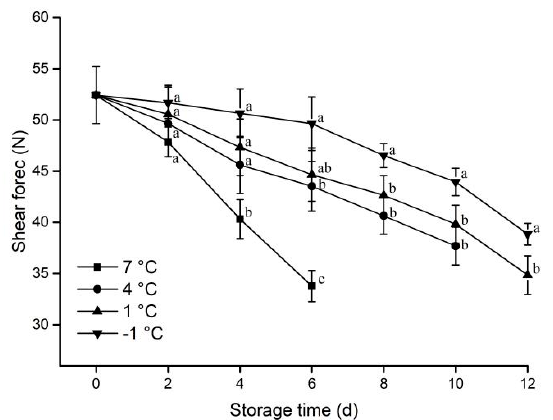
Figure 3. Effect of different storage temperatures on shear force of pork. Different lowercase letters (a − c) indicate significant difference ( p < 0.05) between each treatment on the same storage time. Shear values decreased with increasing storage time for the four treatment groups.